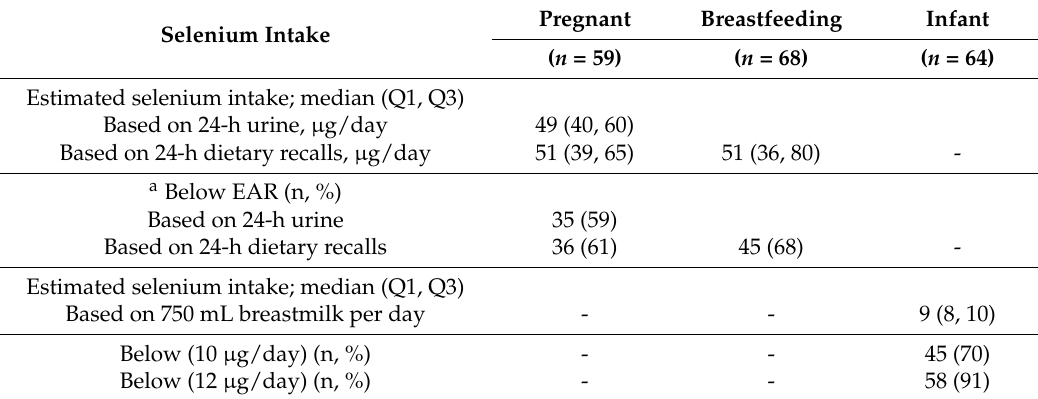
Table 3. Estimated selenium intake in pregnant and breastfeeding women, infants and comparison to